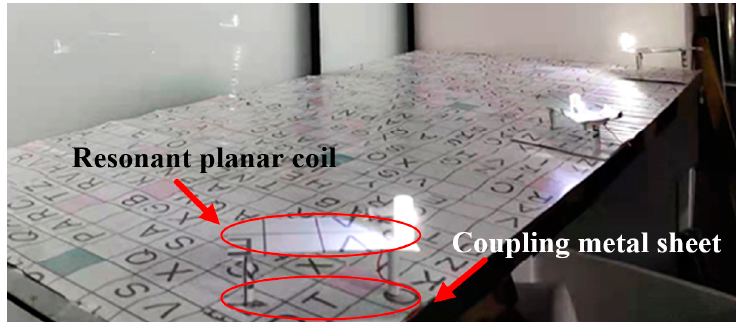
Figure 17. Multiload experiment of DWPT system.